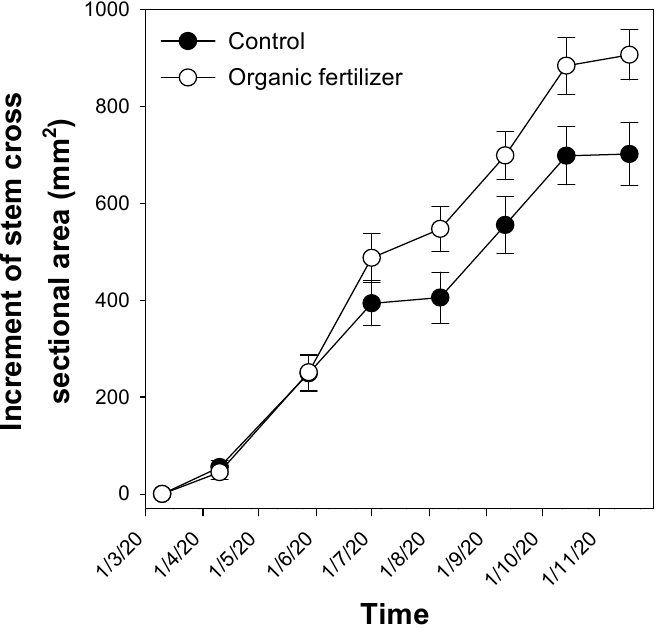
Figure 4. Increment of the trunk cross sectional area of organically fertilized trees (organic fertilizer) and of chemically fertilized ones (control) in the field during the vegetative season of 2020. Bars represent standard errors ( n = 3). Table 1. Tree yield and yield efficiency of treated (organic fertilizer) and control (chemical fertilizer) trees in the field 1 . Treatment